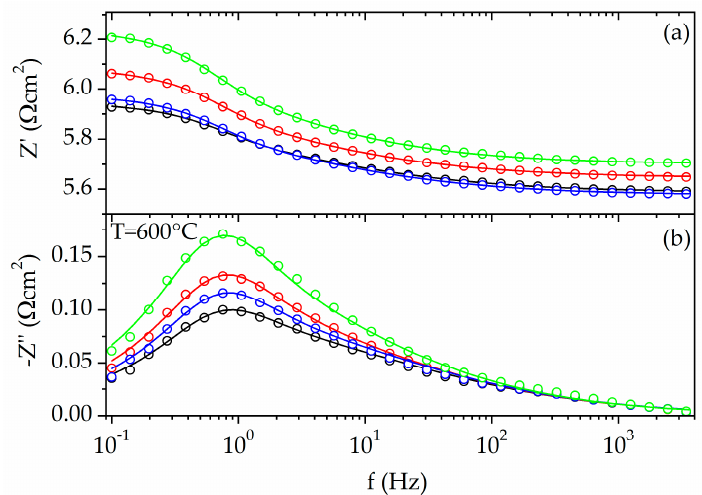
Figure 2. Real ( a ) and imaginary ( b ) part of impedance spectra of BSCF at 600 °C and for various bias levels: black = 0 V, blue = − 0.05 V, red = − 0.1 V, and green = − 0.2 V. Symbols represent experimental data, lines represent the best fit of data obtained by equivalent circuit described in the text.